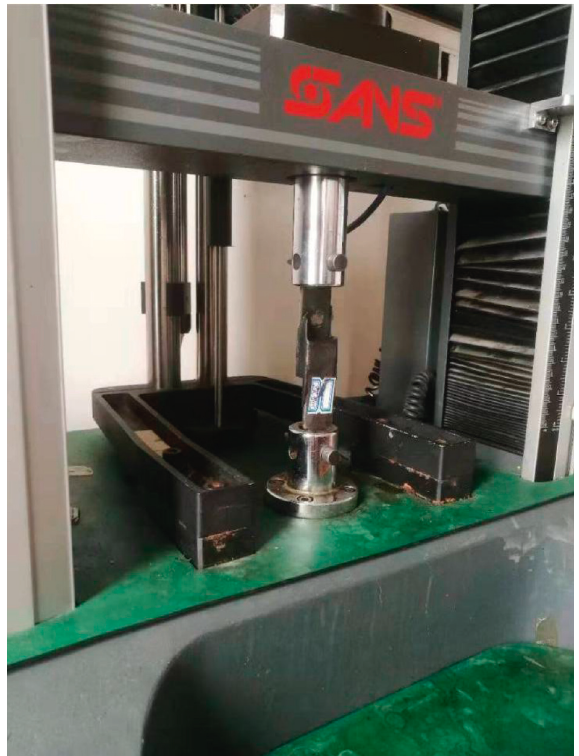
Figure 2: SANS universal material testing